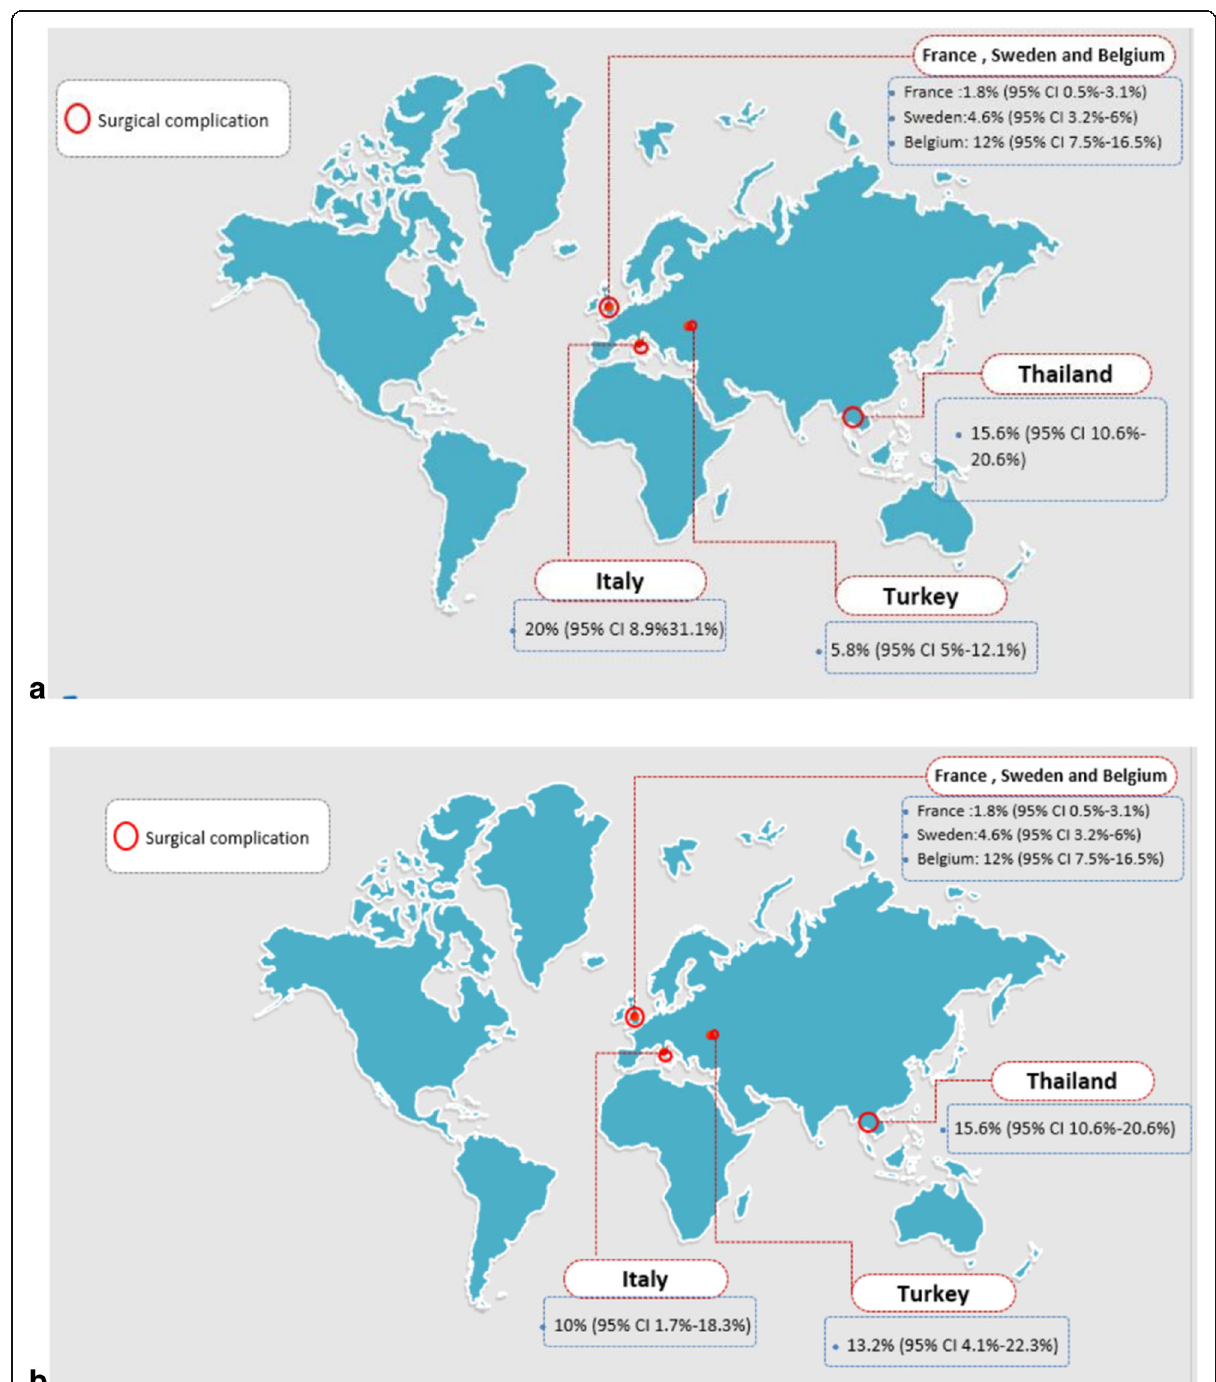
Fig. 8 Prevalence of neurological ( a ) and surgical ( b ) complications of epilepsy surgery based on